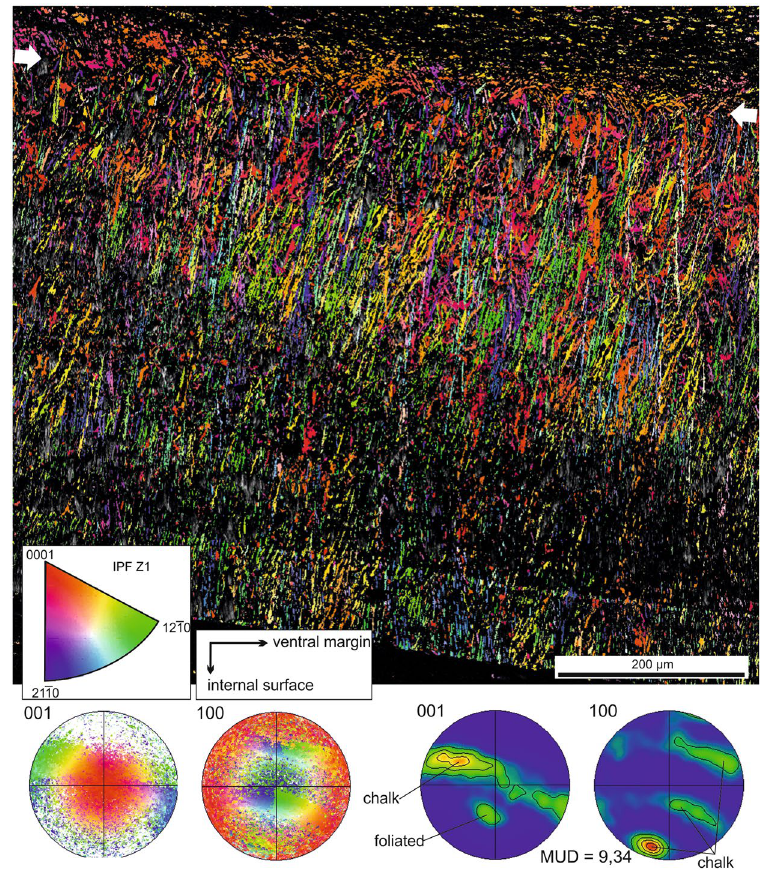
Figure 5. Orientation map covering the complete thickness of a chalk lens. The arrows indicate the boundary with the foliated layer (top). The pole figure maxima corresponding to either material are indicated. The orientation map is superimposed onto the image quality map. IPF, Inverse pole figure (orientation color